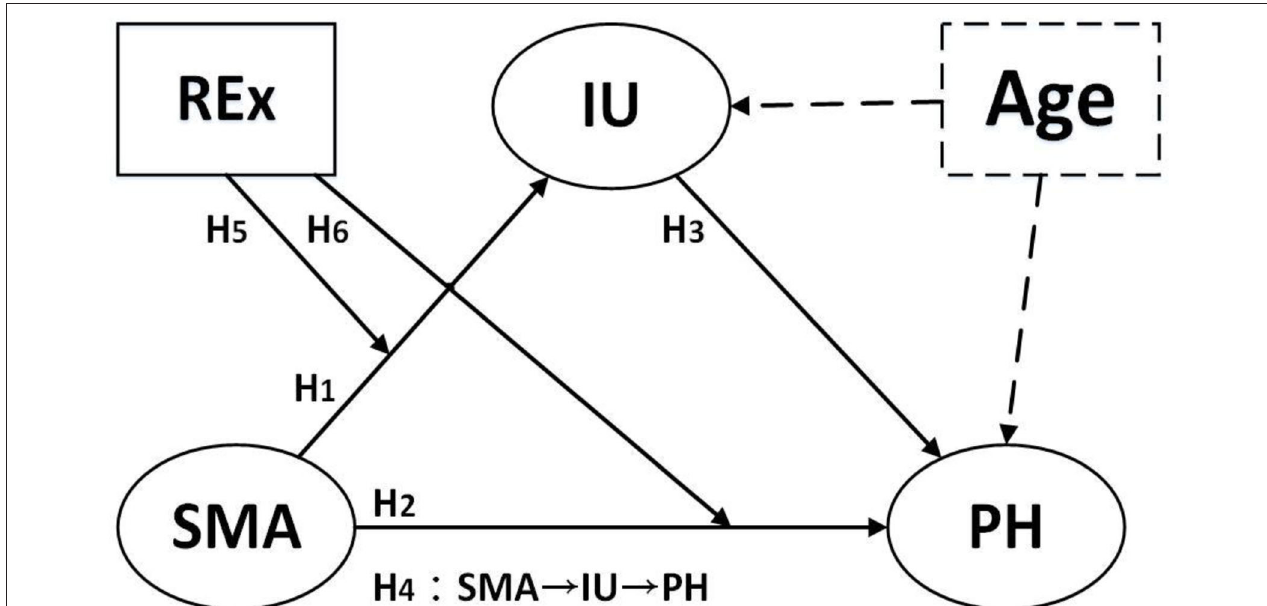
FIGURE 1 | Research model. Age is a controlled